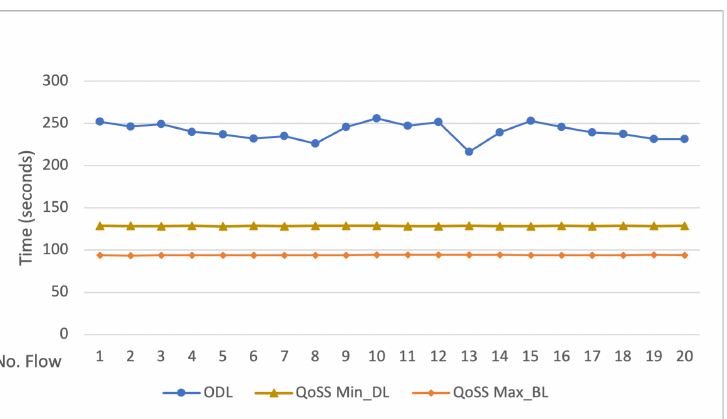
Figure 6. ODL vs. QoSS API optimization rules comparison. Time elapsed (in seconds) for each test to transfer 1 GB of raw